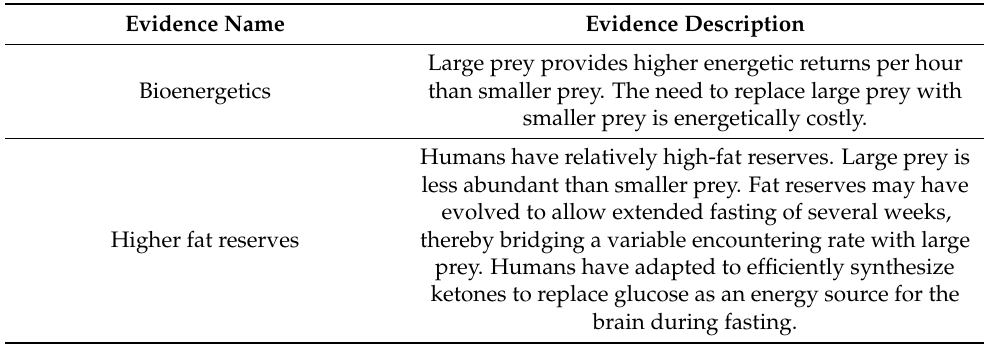
Table 2. Evidence for humans’ specialization in the acquisition of large prey during the